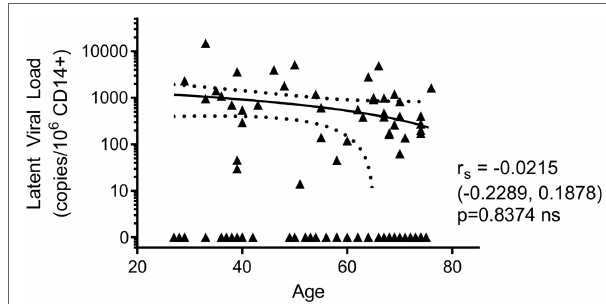
FigUre 7 | There was no effect of donor age on the magnitude of latent human cytomegalovirus (HCMV) load in CD14 + monocytes. The DNA of purified CD14 + monocytes was extracted and HCMV viral load detected using droplet digital PCR analysis. No HCMV was detected in 14 HCMV seronegative donors tested. The HCMV viral load (copies/10 6 CD14 + cells) results from 94 HCMV seropositive donors are shown correlated with donor age. Spearman rank correlation [Spearman r s (95% confidence intervals) and p values] analysis is indicated on the